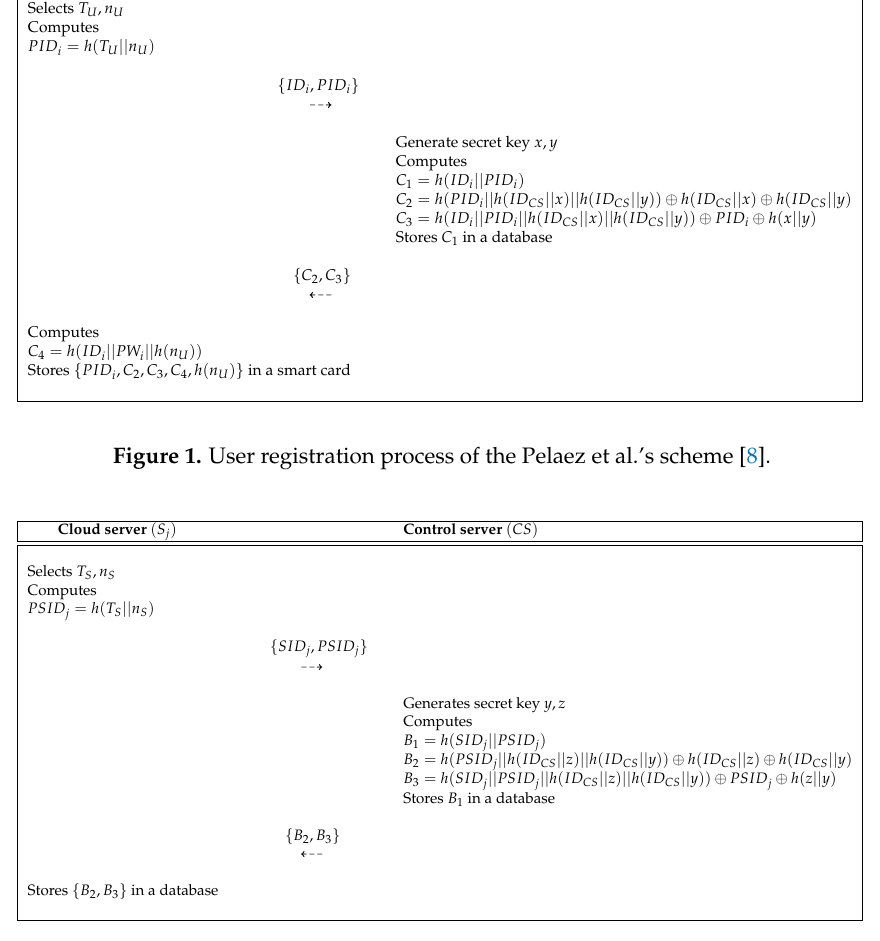
Figure 2. Cloud server registration process of the Pelaez et al.’s scheme [8].